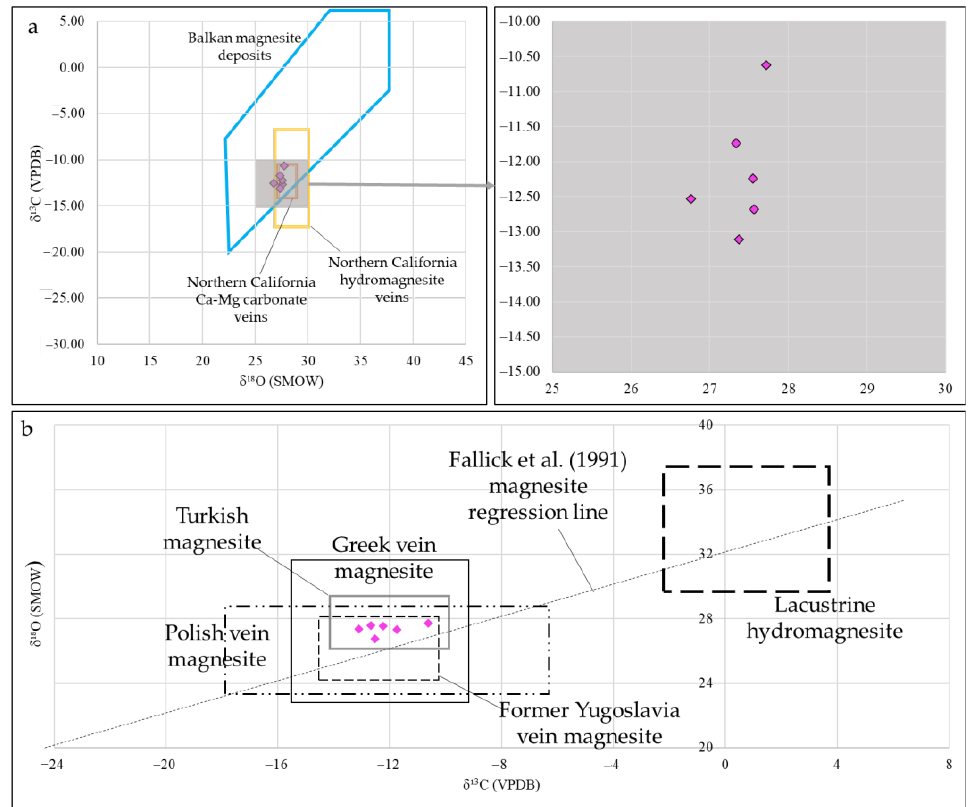
Figure 11. δ 13 C vs. δ 18 O ( a ) and δ 18 O vs. δ 13 C ( b ) of Kymasi magnesite. Compositional fields are: Balkan magnesite deposits [59], Northern California hydromagnesite veins [9], Northern Cal- ifornia Ca-Mg carbonate veins [9], Turkish magnesite [65], Polish vein magnesite [64], Greek vein magnesite [67], former Yugoslavian vein magnesite, and lacustrine hydromagnesite